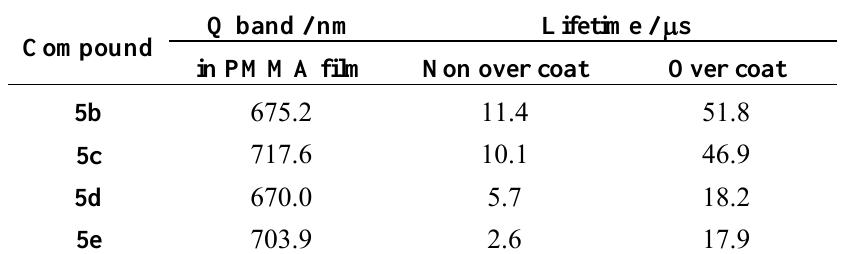
Table 9. Triplet lifetime of alkylbenzopyridoporphyarazines, 5b - 5d and 5e .